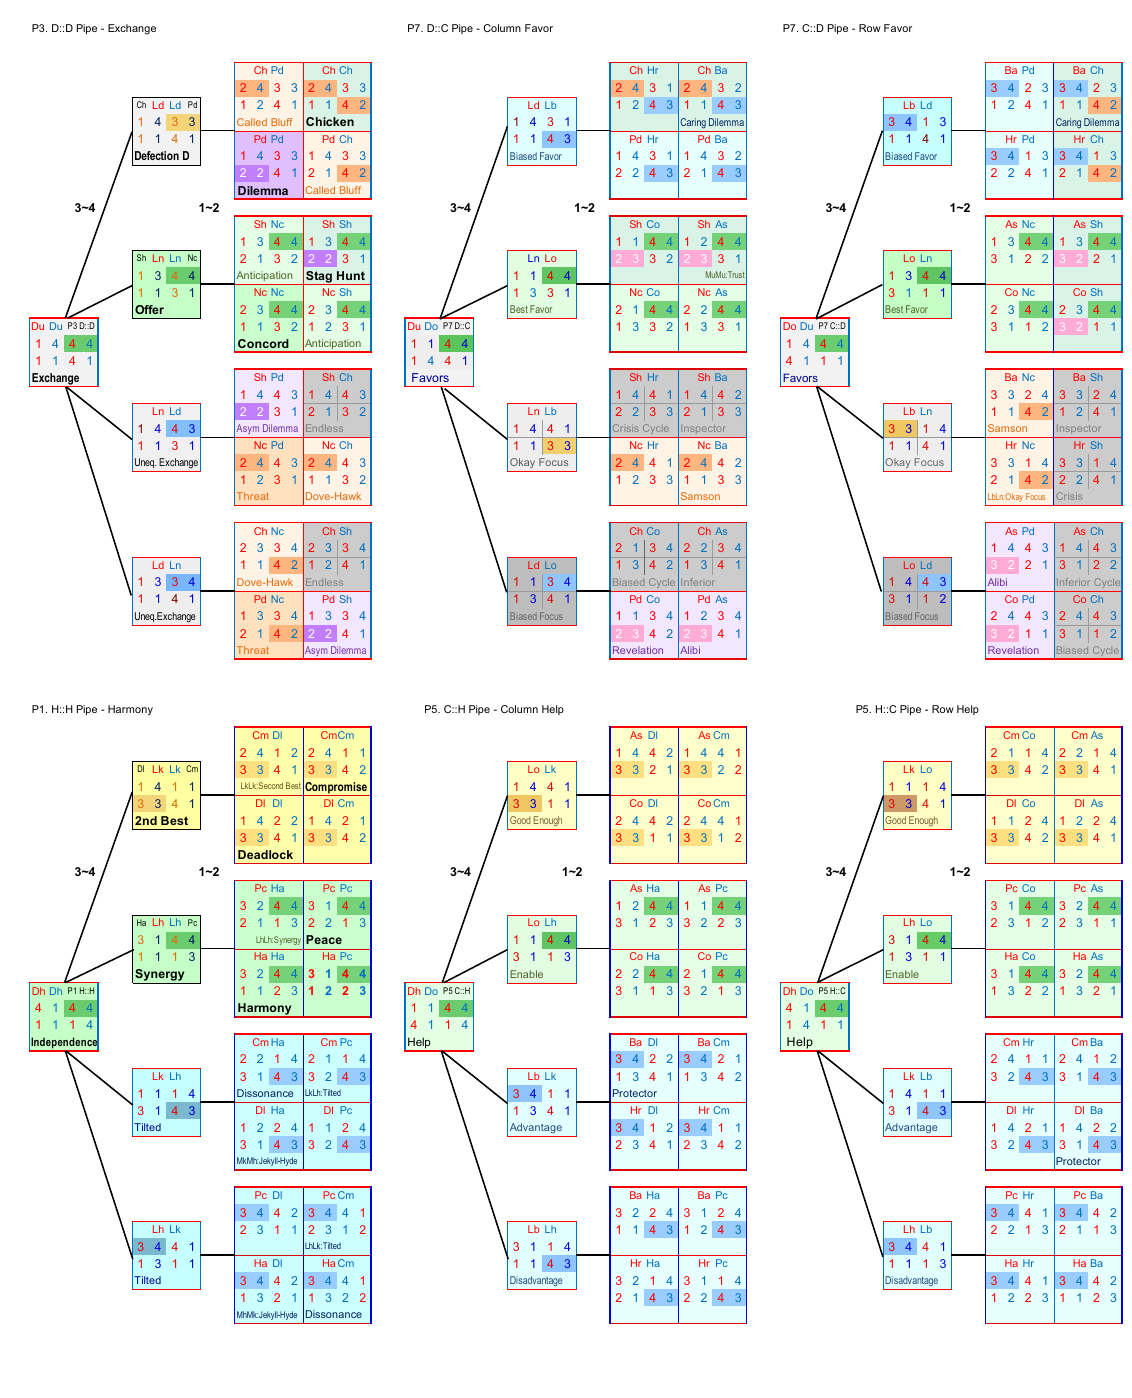
Figure A2. Pipe families. Primal archetypes for Exchange, Independence (Harmony), Favors, and Help differentiate into four tiles with sixteen strict